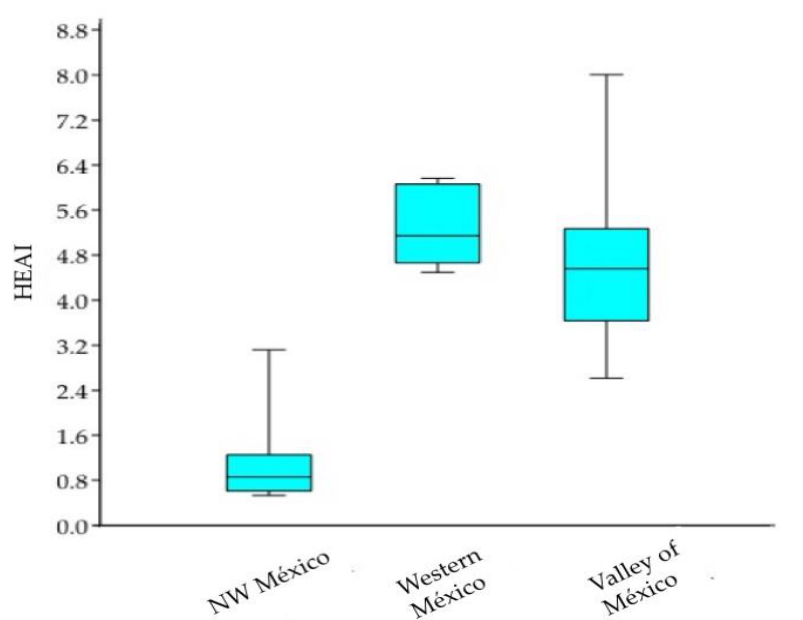
Figure 8. ANOVA graphical display for HEAI grouped in three regions of Suaeda spp.